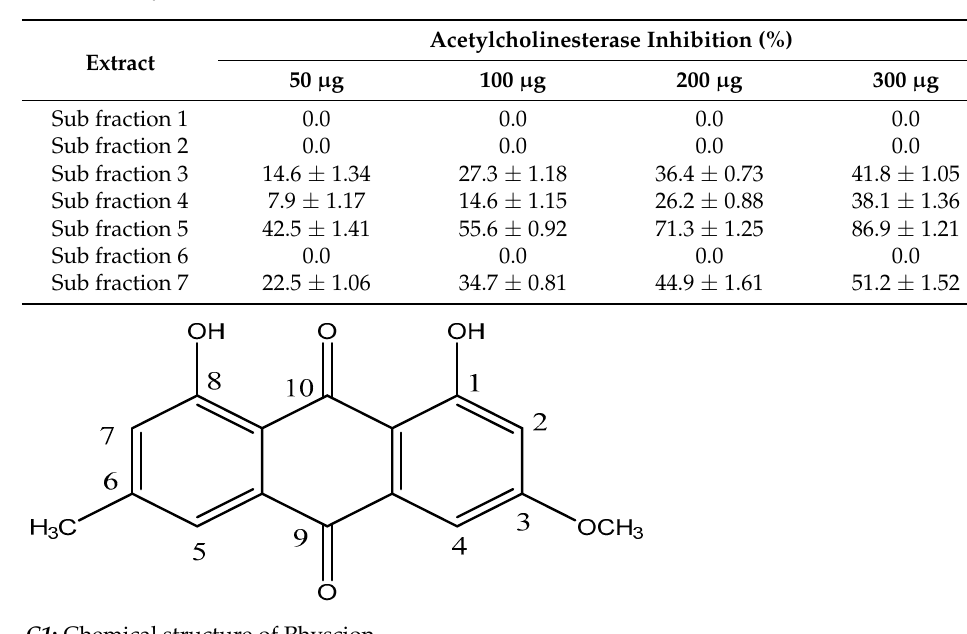
Table 3. Acetylcholinesterase inhibition (%) of different sub-fraction from Fraction 3.